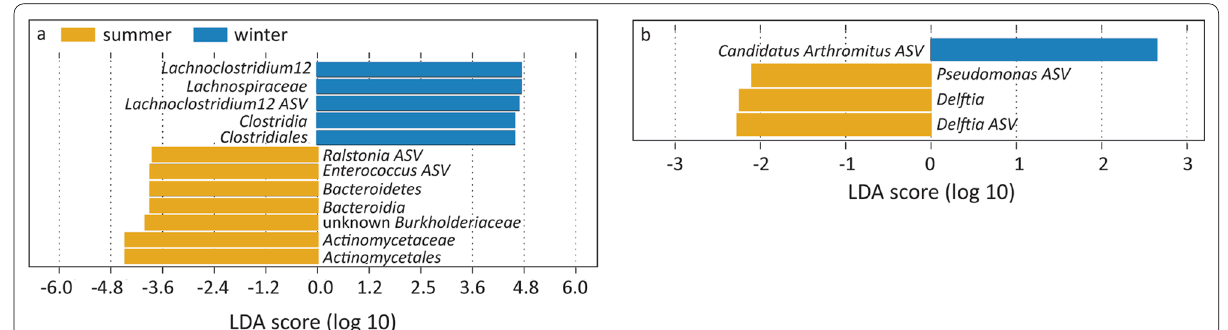
Fig. 6 Seasonal LEfSe associates per sex, and the significant LMM results in individual associates. a Associates that were more abundant in summer (negative values) or winter ( positive values) in male homing pigeons. b Associates that were more abundant in summer or winter in female − homing